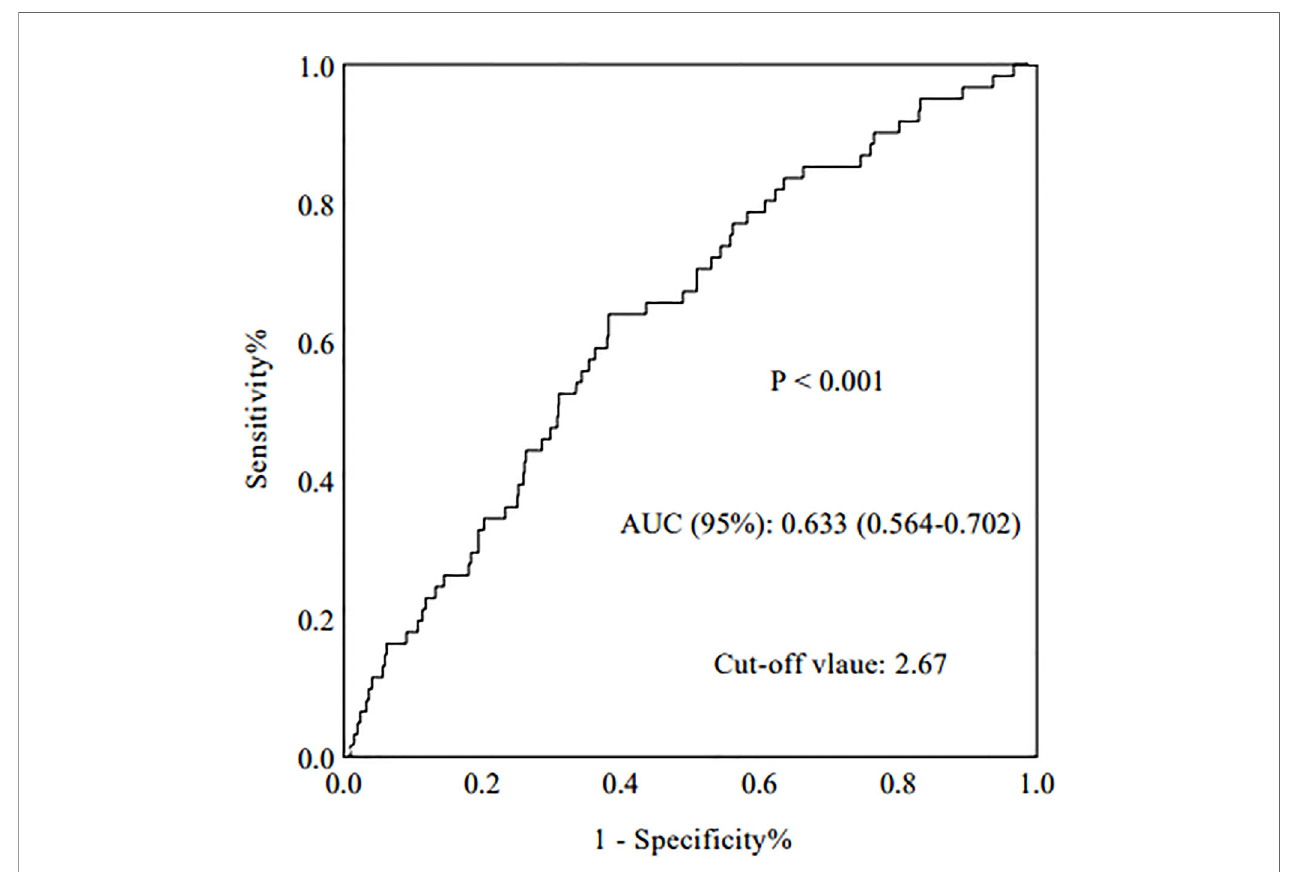
FIGURE 2 | The areas under the ROC curves (AUCs) of